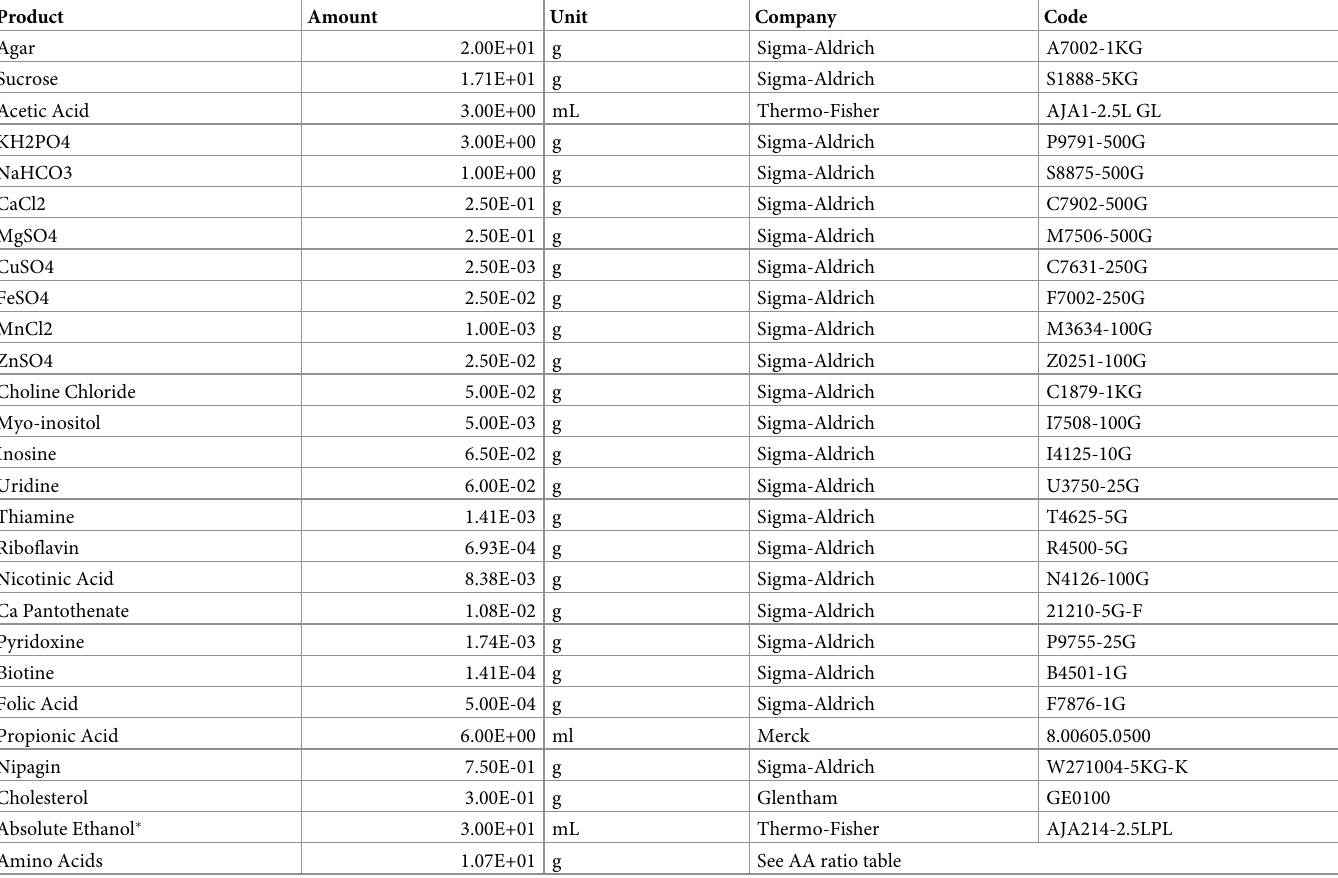
Table 4. Product amounts in 1000mL of Holidic